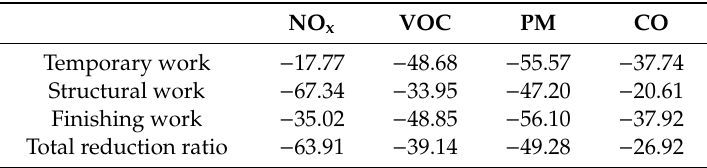
Table 6. Reduction of the total pollutant emissions (Unit: